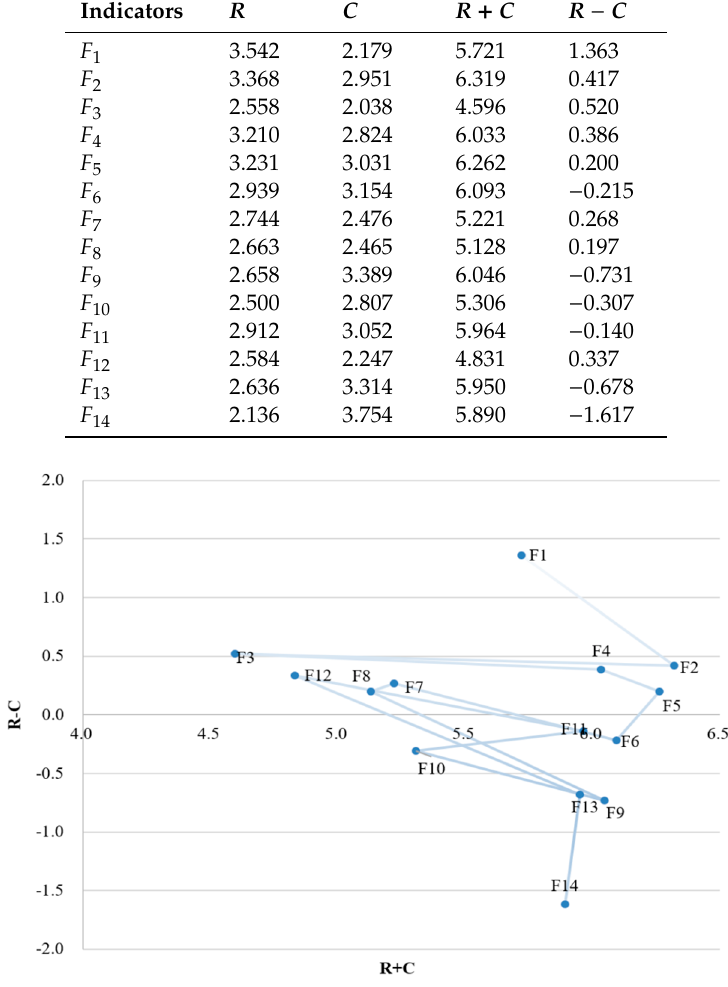
Figure 2. Causal diagram of performance indicators.